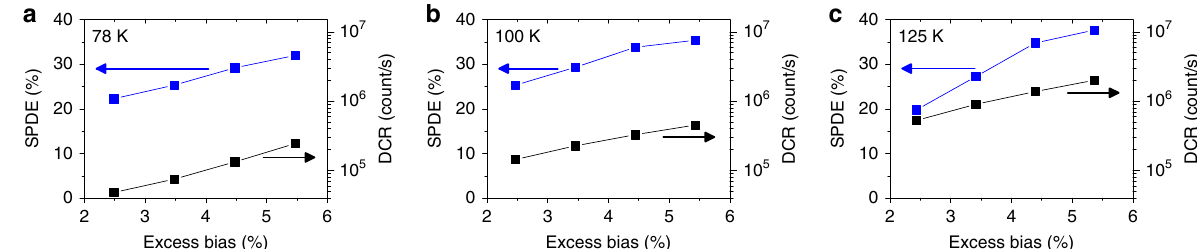
Fig. 3 Ge-on-Si single-photon avalanche diode (SPAD) performance. Single-photon detection ef fi ciency (SPDE) and dark count rate (DCR) as a function of excess bias for a 100 µ m diameter SPAD at temperatures of a 78 K, b 100 K and c 125 K. The measurements were taken using the time-correlated single- photon counting (TCSPC) technique with a 50 ns electrical gate applied to the detector to bias it above avalanche breakdown. For the SPDE measurements the gate was synchronised with the arrival of the 1310 nm wavelength attenuated laser pulse. The detector was gated at a repetition rate of 1 kHz